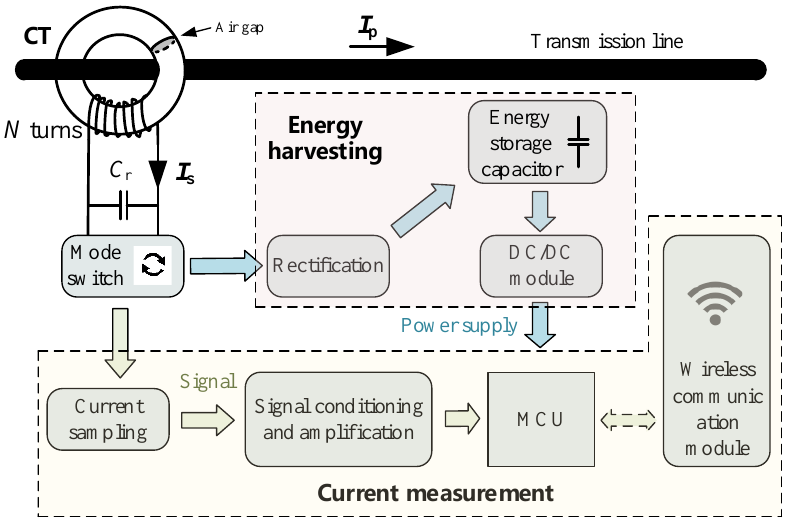
Figure 7. System structure of the time-multiplexed self-powered wireless current sensor.